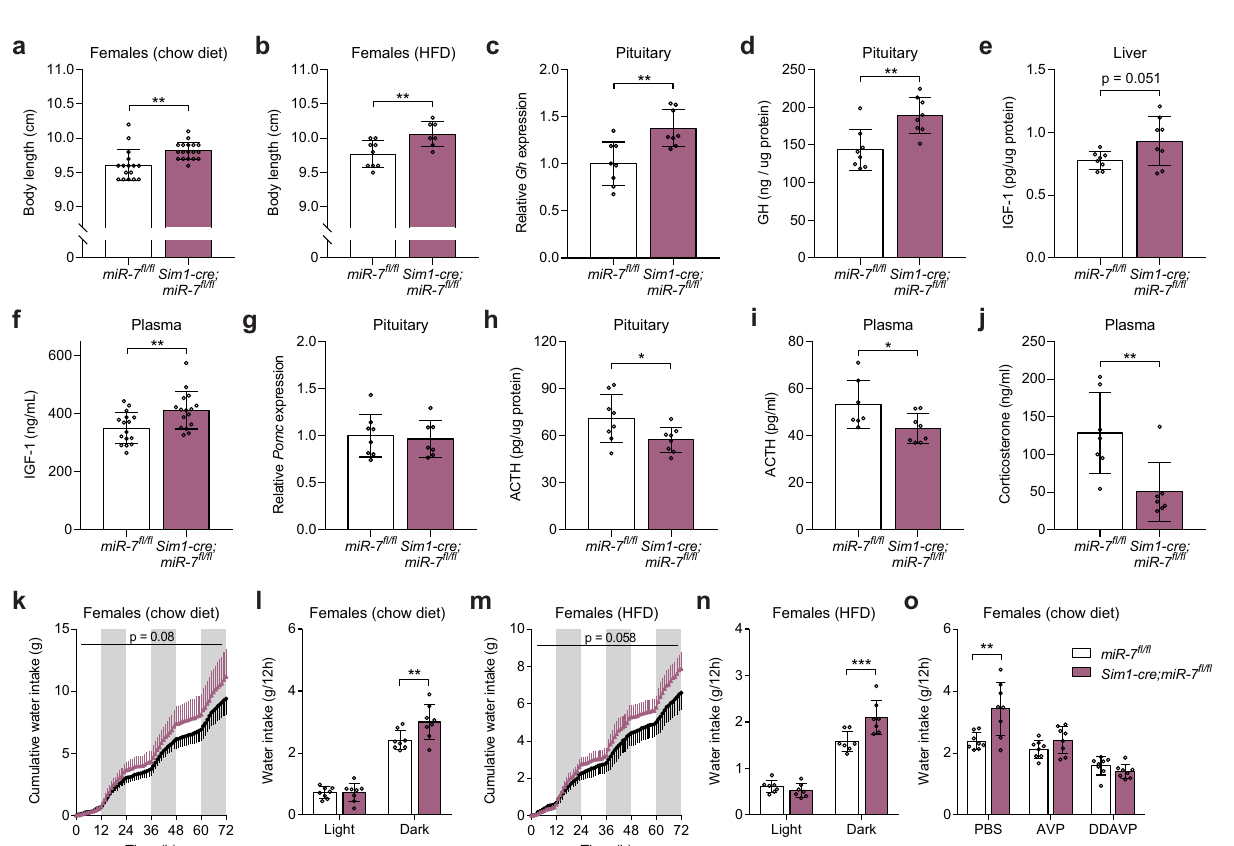
Fig. 2 | Obesity, hyperphagia, and increased insulin secretion upon deletionof mir-7 in Sim1neurons.a Experimental strategy to assess the functions of miR-7 in hypothalamicneuronpopulations. b – e Bodyweightofchow-fedmale( n =15and13 animals)( b ),chow-fedfemale( n =8and11animals)( c ),HFD-fedmale(n=10and19 animals) (d), and HFD-fed female ( n =18 and 13 animals) ( e ) mir-7 fl / fl and Sim1- cre;mir-7 fl / fl mice. f RepresentativephotographofHFD-fedfemale mir-7 fl / fl and Sim1- cre;mir-7 fl / fl mice. g – h Maleandfemalebodyweightin20week-oldchow-fed( g )and HFD-fed ( h ) mir-7 fl / fl and Sim1-cre;mir-7 fl / fl mice, using data shown in Fig. 2b – e. Dashedlineindicatesthe bodyweightof mir-7 fl / fl males. i – j Leanand fat mass( n =8 animals) ( i ) and adipose depot mass ( n =4 animals) ( j ) of HFD-fed female mir-7 fl / fl and Sim1-cre;mir-7 fl / fl mice. k – p 72-hour metabolic cage measurements of HFD-fed female mir-7 fl / fl and Sim1-cre;mir-7 fl / fl mice ( n =7 animals). ( k) Cumulative food intake; ( l ) average food intake per 12-h phase; ( m ) hourly energy expenditure; ( n ) average energy expenditure per 12-hour phase; ( o ) cumulative locomotor activity;